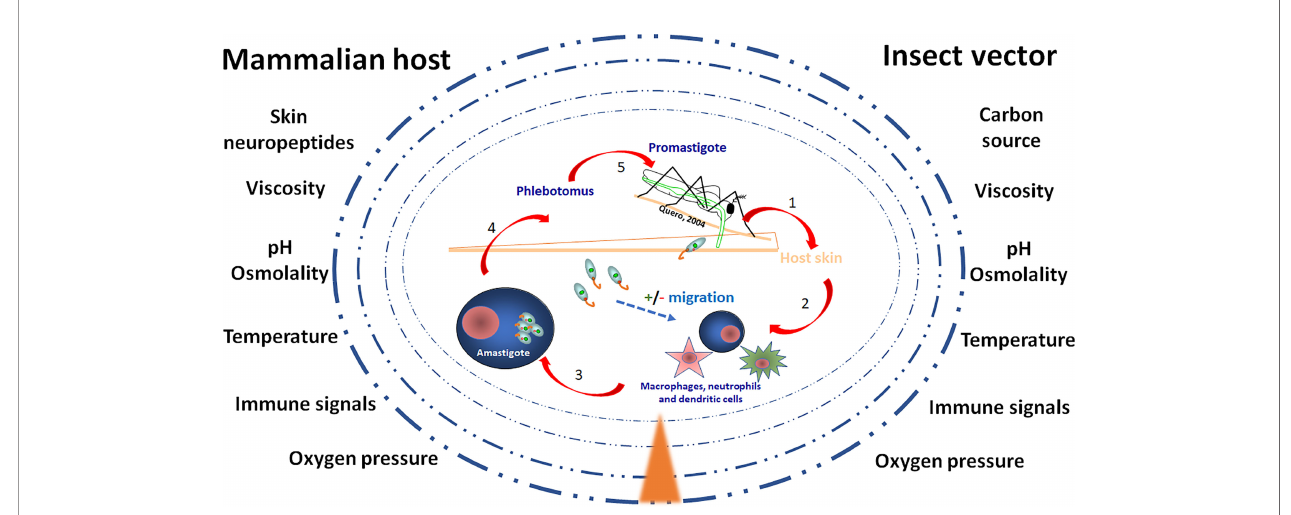
FIGURE 1 | The environment of Leishmania in the vector and the host skin. The fi gure illustrates the gradient ( ▲ ) of environmental compounds and signals to which Leishmania parasites are exposed during their life cycle. Once the vector bites and Leishmania parasites enter the skin, unique mammalian host signals constituted by various neuropeptides and neuropeptide-like mediators are released, potentially modulating migration of parasites towards or against their host cells, being macrophages, neutrophiles and dendritic cells. After a blood meal by the female sand fl y vector parasites reach the gut microenvironment where growth and development as morphologically distinct forms of extracellular promastigotes is also subjected to unique signals. The challenges to which the parasites are exposed include carbon nutrients, immune signals, skin neuropeptides, osmolality, oxygen pressure, pH, temperature,